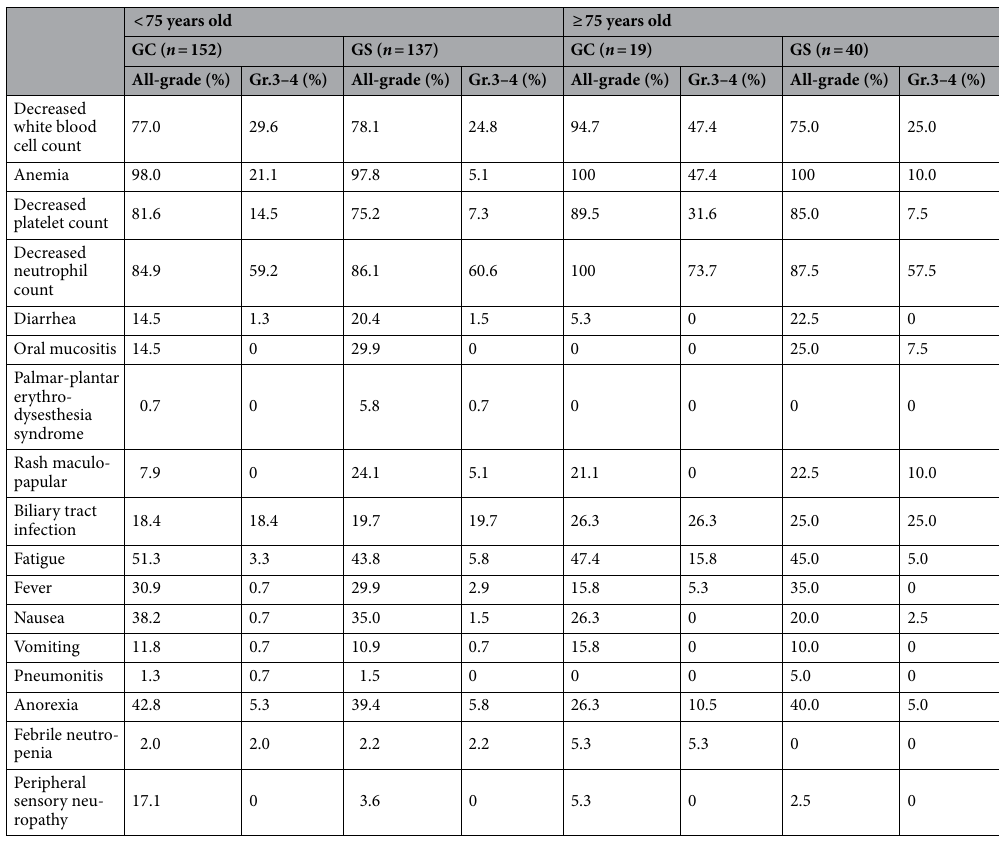
Table 3. Summary of adverse events data according to CTCAE v4.0 (safety analysis set). There were three treatment-related deaths in the GC group and none in the GS group. GC, gemcitabine plus cisplatin; GS, gemcitabine plus